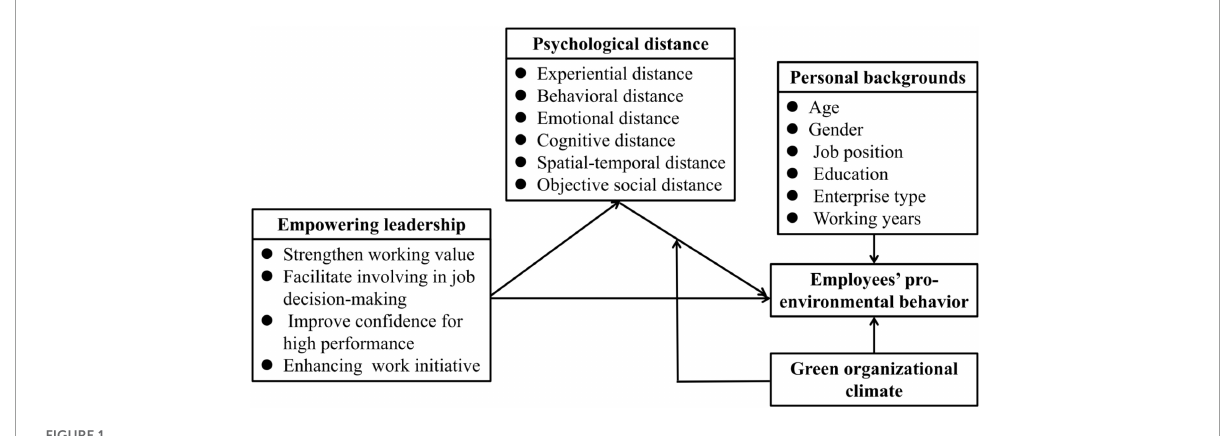
FIGURE1 Hypothesis model.